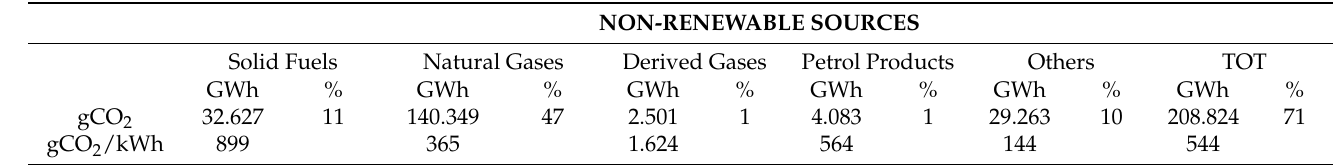
Table 6. Emissions caused by non-renewable sources of energy.